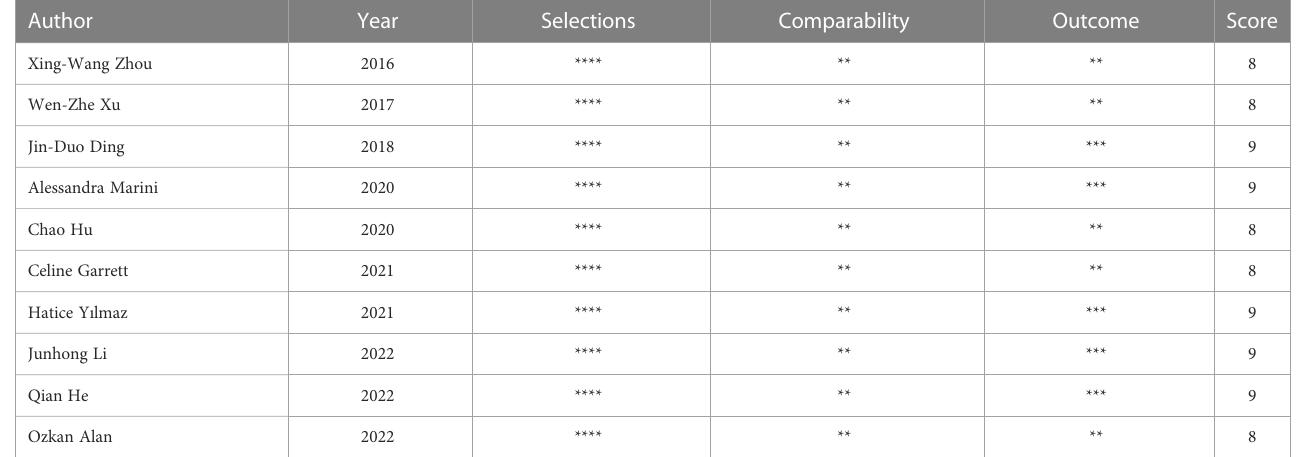
TABLE 2 Quality evaluation of included studies using the Newcastle Ottawa Scale for cohort